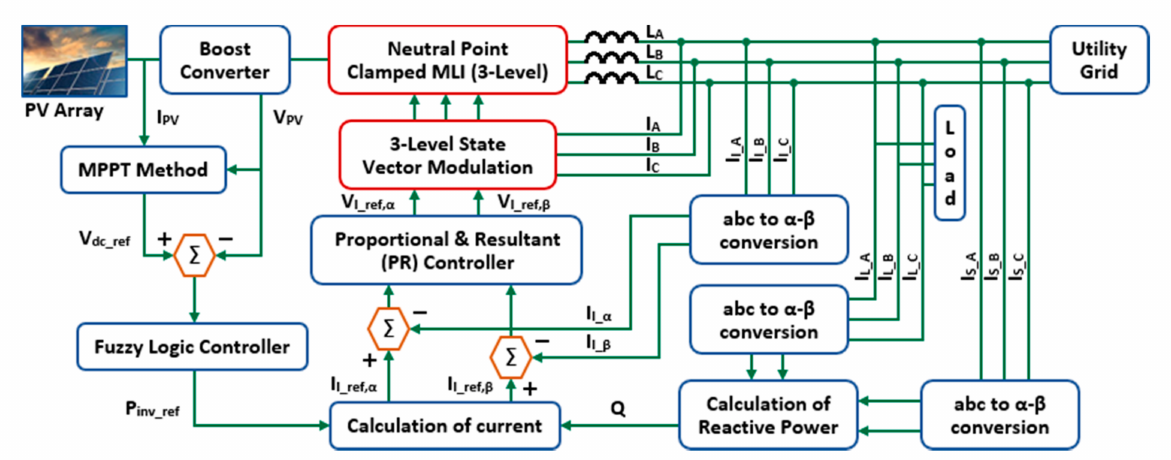
Figure 29. Block diagram of the dual loop control method for a three-level inverter.